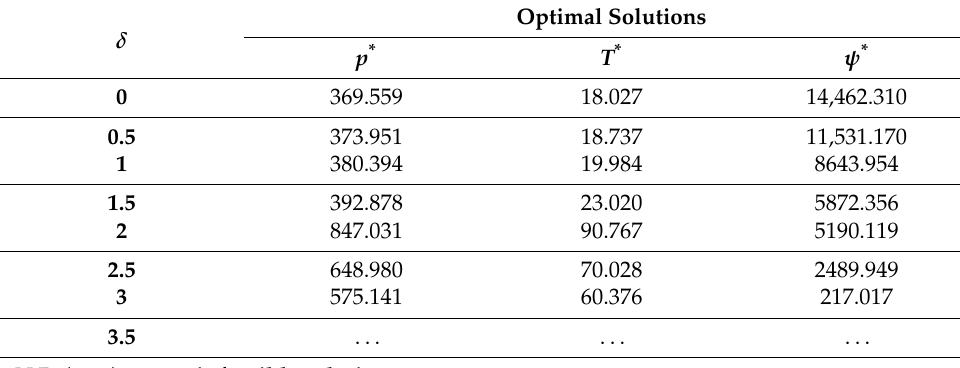
Table 2. Results for each inventory